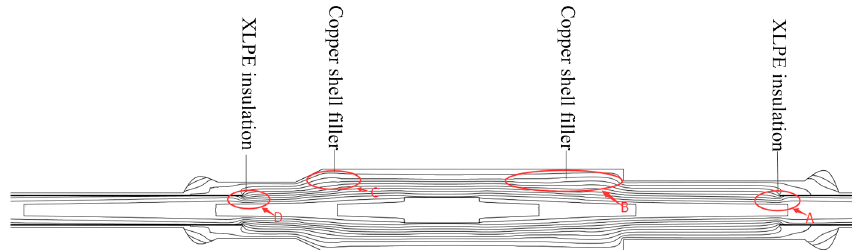
Figure 7. Isotherm distribution of steady-state temperature field in the cable joint.